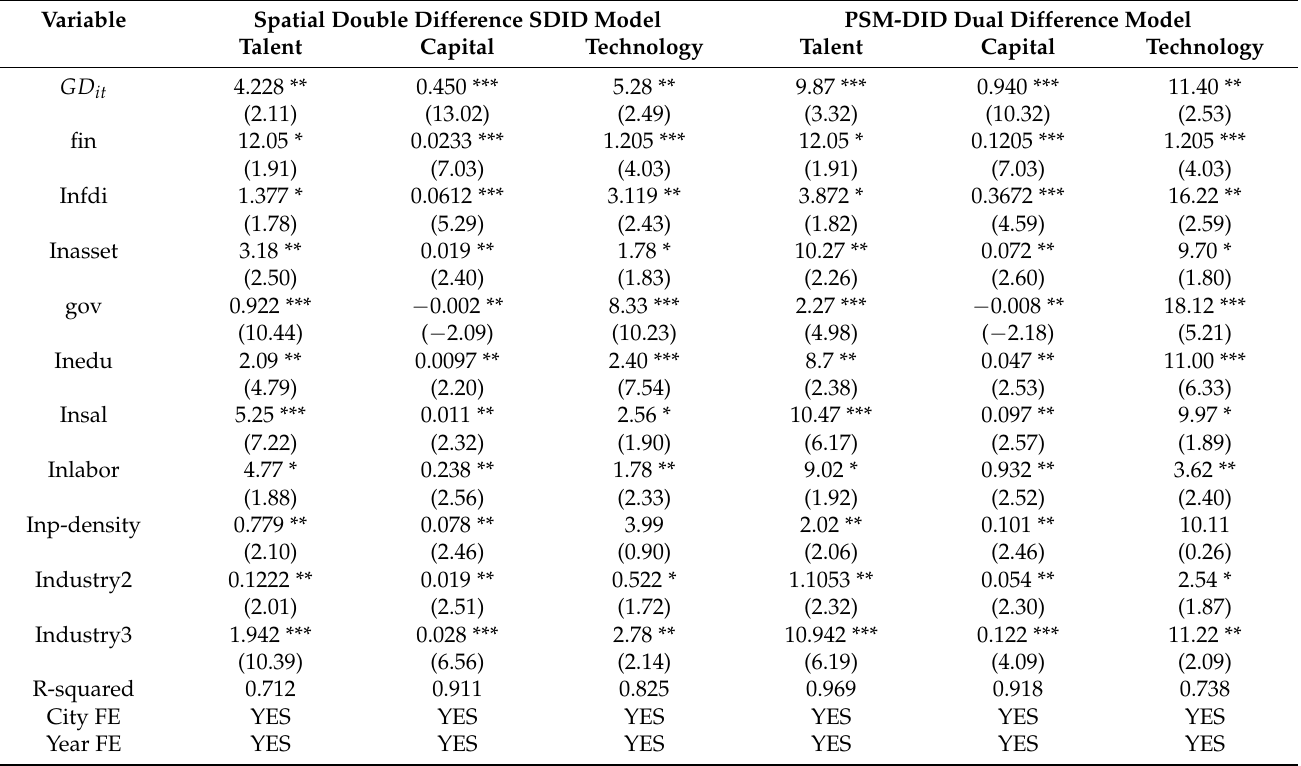
Table 10. Regression results of